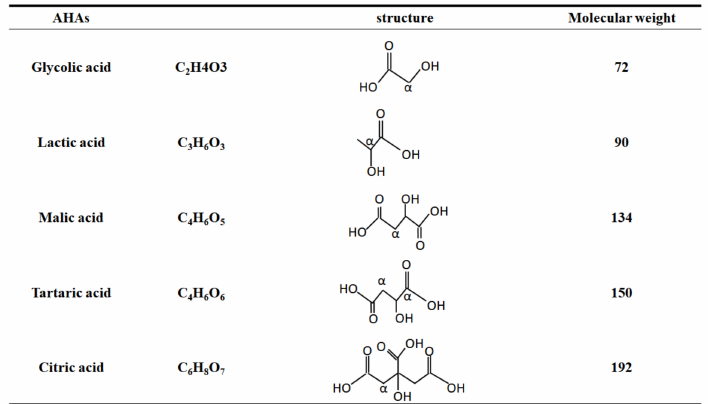
Figure 1. The structures of AHAs commonly used in dermatology including glycolic acid, lactic acid, malic acid, tartaric acid, and citric acid. AHAs are weak organic acids with one or more hydroxyl group attached to the alpha carbon, indicating α . Malic acid and citric acid contain a hydroxyl group in the α -position to one carboxyl group and in the β -position to the other carboxyl group. Tartaric acid is a dicarboxylic acid with two hydroxyl groups at the alpha position of the acid. Malic acid and citric acid are also prominent representatives in alpha hydroxyl acids and beta hydroxyl